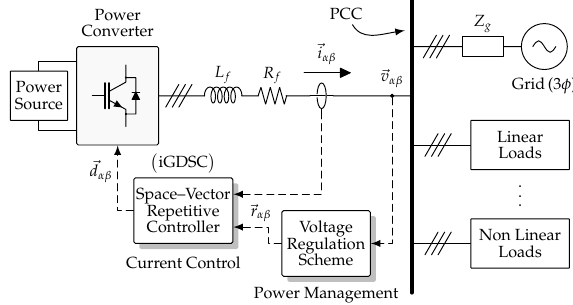
Figure 1. Voltage regulation system with SV-RC